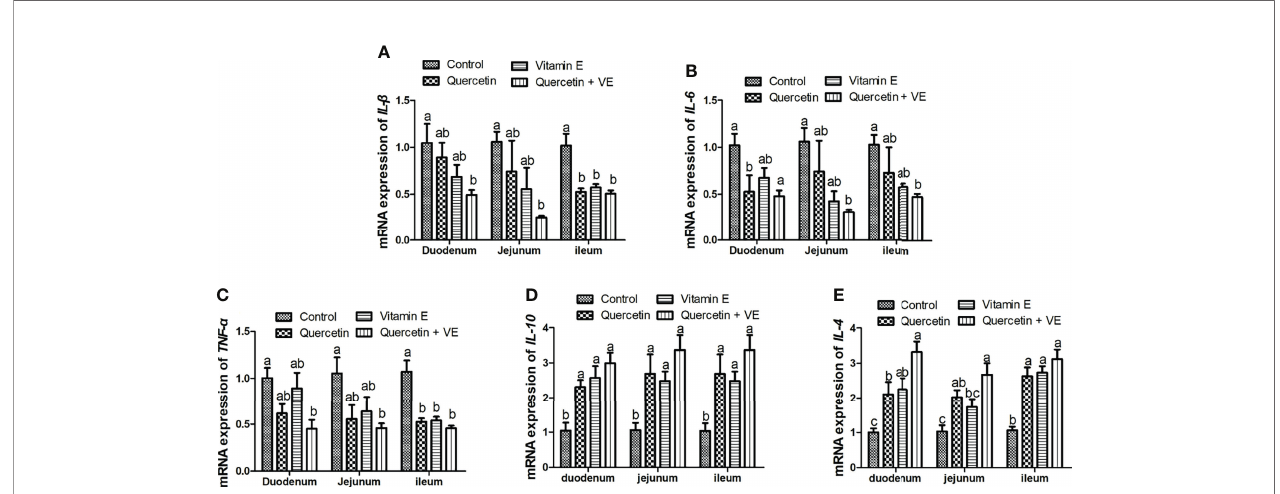
FIGURE 4 | Effects of Q, VE, and Q + VE on the mRNA expressions of pro- and anti-in fl ammation related cytokines ( IL-6, IL-1 b , and TFN- a ; IL-10 and IL-4 ) related genes in the small intestinal mucosa of aged breeder hens. mRNA expressions of pro-in fl ammatory cytokines (A – C) and anti-in fl ammatory cytokines related genes (D, E) . Bars without the same letter differed signi fi cantly (P <